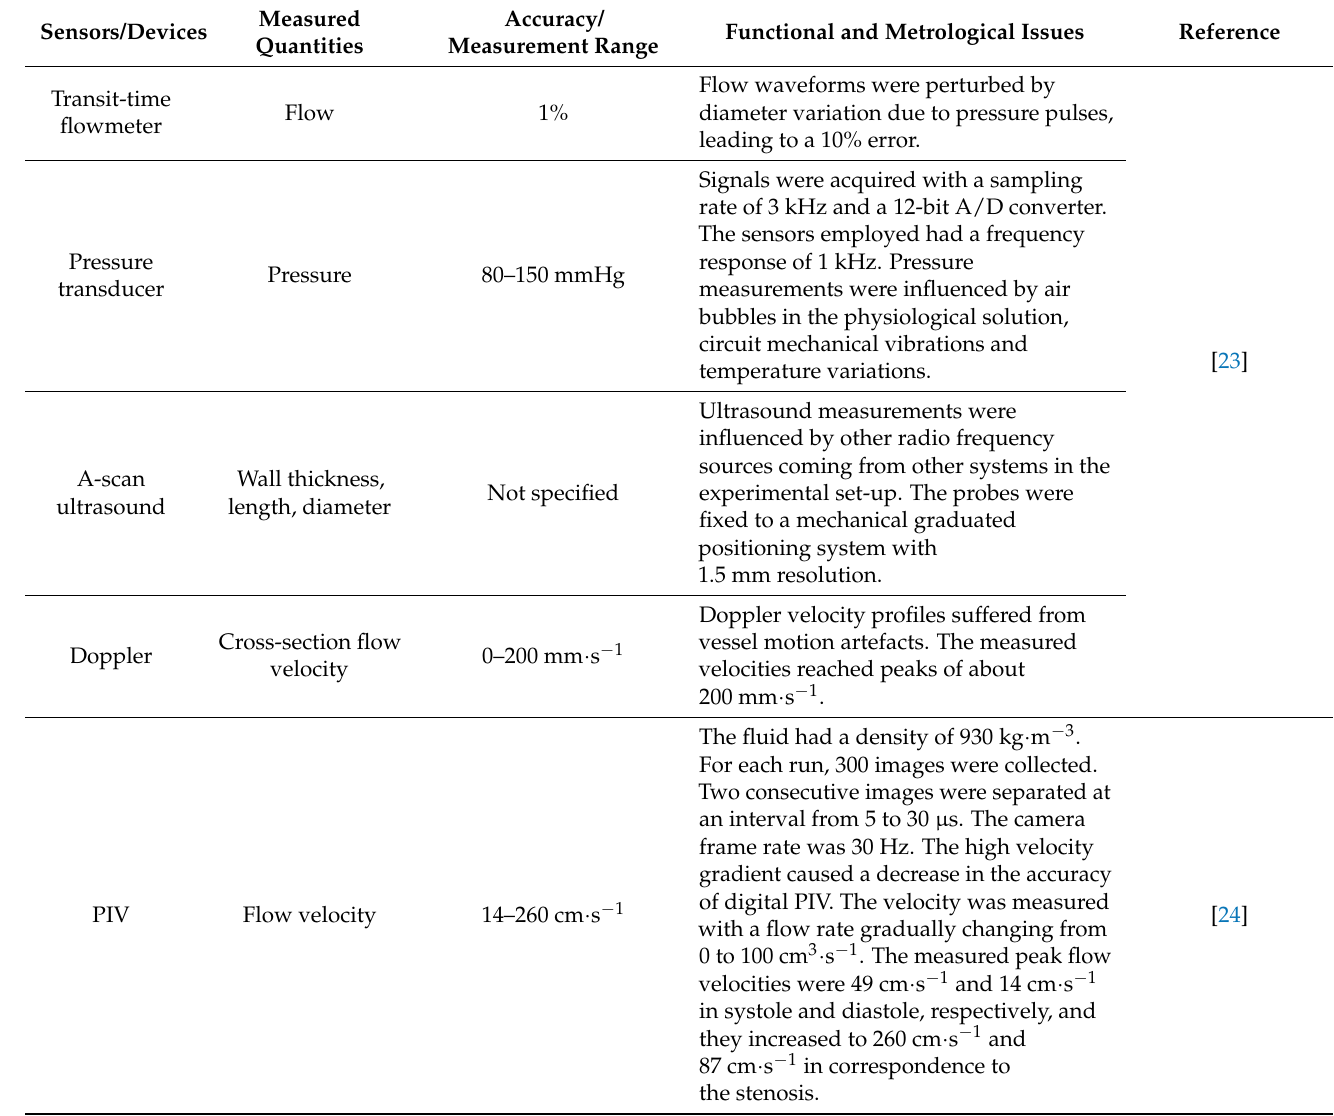
Table 2. Overview of artery bifurcation